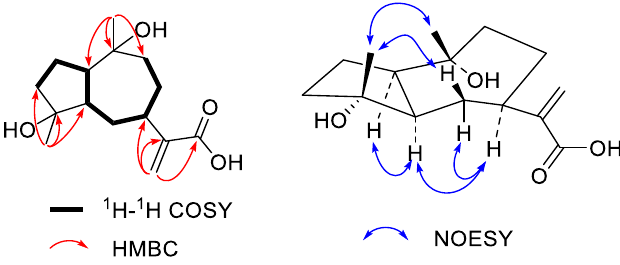
Figure 2. Key 1 H- 1 H COSY, HMBC, and NOESY correlations of 1 . Compound 2 was obtained as a colorless syrup. The molecular formula of 2 was C 17 H 28 O 4 as determined by the HRESIMS peak at m/z 615.3872 ([2M +Na] + , calcd. for 615.3873) with four degrees of unsaturation. The 1 H NMR data (Table 1) show signals of four tertiary methyls at δ H 1.22 (d, H 3 -13), 1.15 (s, H 3 -14), 1.33 (s, H 3 -15), and 1.11 (t, H 3 -2 ’ ) and an oxygenated methine at δ H 4.23 (H-6) and an oxygenated methylene at 3.37 (H 2 -1 ’ ). The 13 C NMR data of 2 (Table 2) identify 17 resonances ascribed to four methyls, five methylenes (one oxygenated), five methines (one oxygenated), two oxygenated tertiary carbons, and one ester carbonyl carbon. The 1 H and 13 C NMR data of 2 (Tables 1 and 2) display characteristic signals of a guaiane-type sesquiterpenoid, which quite resembled that of α -Hydroxy-10 α -methoxyguaian-12,6-olide [13]. A careful comparison of 1 H and 13 C NMR data and molecular formula showed that ethoxyl, rather than methoxyl, existed at C-10 in 2 . The relative configuration of 2 was deduced from the NOE correlations (Figure 3). The cross peaks of H-1/H-5, H-5/H-7, and H-7/H 3 -13 indicated that these protons were cofacial and α -oriented. The cross peaks of H-6/H 3 -16, H-6/H 3 -14, and H-6/H-11 proved that they were on the opposite face and were assigned to be β -oriented. Accordingly, com- pound 2 was determined structurally as 4 α -Hydroxy-10 α -ethoxyguaian-12,6-olide. Table 1. 1 H NMR spectrum (600 MHz) data of compounds 1 − 4. NO.